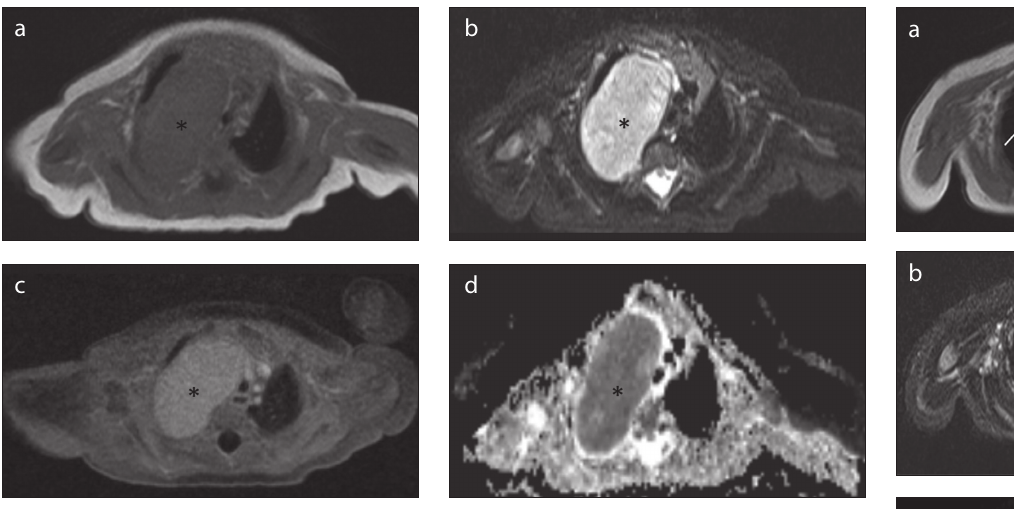
Figure 4. a-d. A 9-year-old female with pathologically confirmed neuroblastoma in the right upper lobe. Axial T1-weighted image (a) reveals hypointense neuroblastoma lesion (black asterisk). Axial T2- weighted image (b) reveals a hyperintense neuroblastoma lesion (black asterisk). Axial postcontrast- enhanced T1-weighted image reveals a distinct contrast enhancement in neuroblastoma lesion (black asterisk). Axial diffusion-weighted (ADC map) image (d) reveals diffusion restriction in the neuroblastoma lesion (black asterisk).